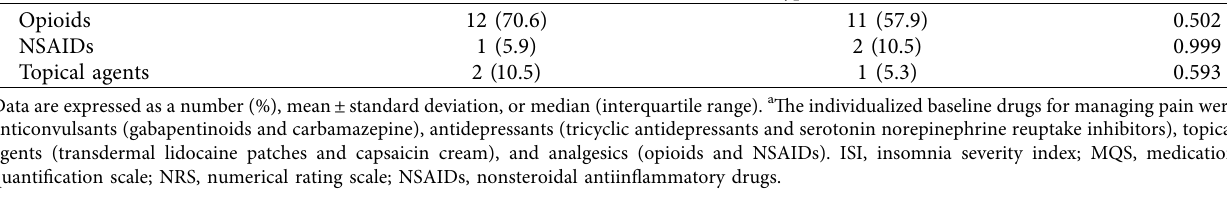
Table 2: Changes in the estimated pain scores after epidural block with or without hypertonic saline in patients with postherpetic neuralgia. Variable